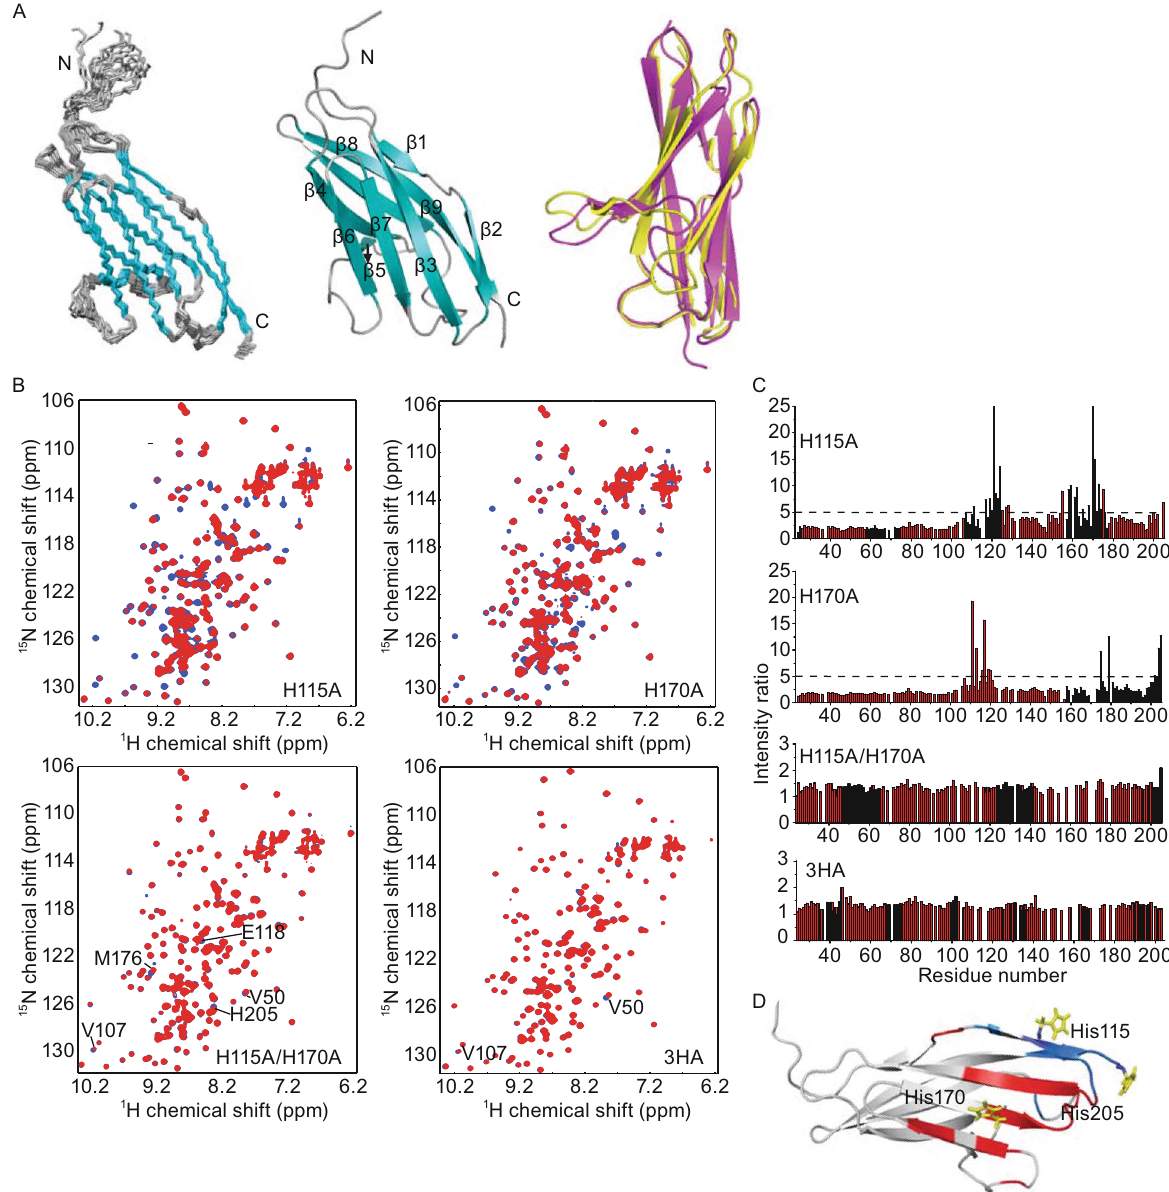
Figure 2. Solution structure of C-CD147 EC and interaction between Zn(II) and CD147 EC mutants . (A) Solution structure of C-CD147 EC . Superimposition of the backbone trace of the 20 representative structures of the C-CD147 EC (left). The ribbon diagram of the mean structure of C-CD147 EC with secondary structural elements labeled (middle). Superimposition of the solution structure (magenta) and the crystal structure (yellow, PDB ID: 3B5H) of the C-CD147 EC (right). (B) Overlay of 2D 1 H- 15 N HSQC spectra of mutants H115A, H170A, H115A/H170A, or H115A/H170A/H205A with (red) or without (blue) 2-fold excess of Zn(II). All samples contain 0.4 mmol/L 15 N-labelled protein. (C) Plot of NH signal intensity ratio for CD147 EC mutants H115A, H170A, H115A/H170A and H115A/H170A/H205A (3HA), between signals with and without 2-fold excess of Zn(II). (D) The NH signal intensity ratio larger than 5 are mapped on the solution structure of C-CD147 EC . Residues affected by Zn(II) in mutant H115A are colored red, while residues affected by Zn(II) in mutant H170A are colored blue. Sidechains of residues His115, His170, and His205 are shown as sticks and labeled with three-letter amino acid code and residue